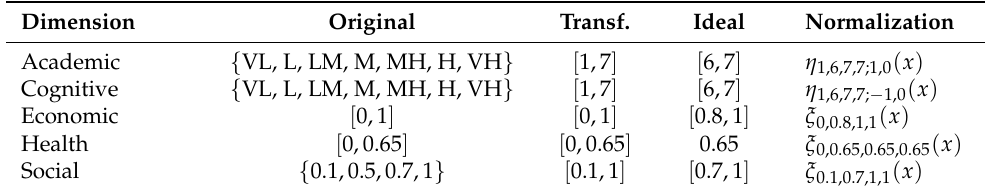
Table 1. Dimensions, ranges, ideals and normalizations.